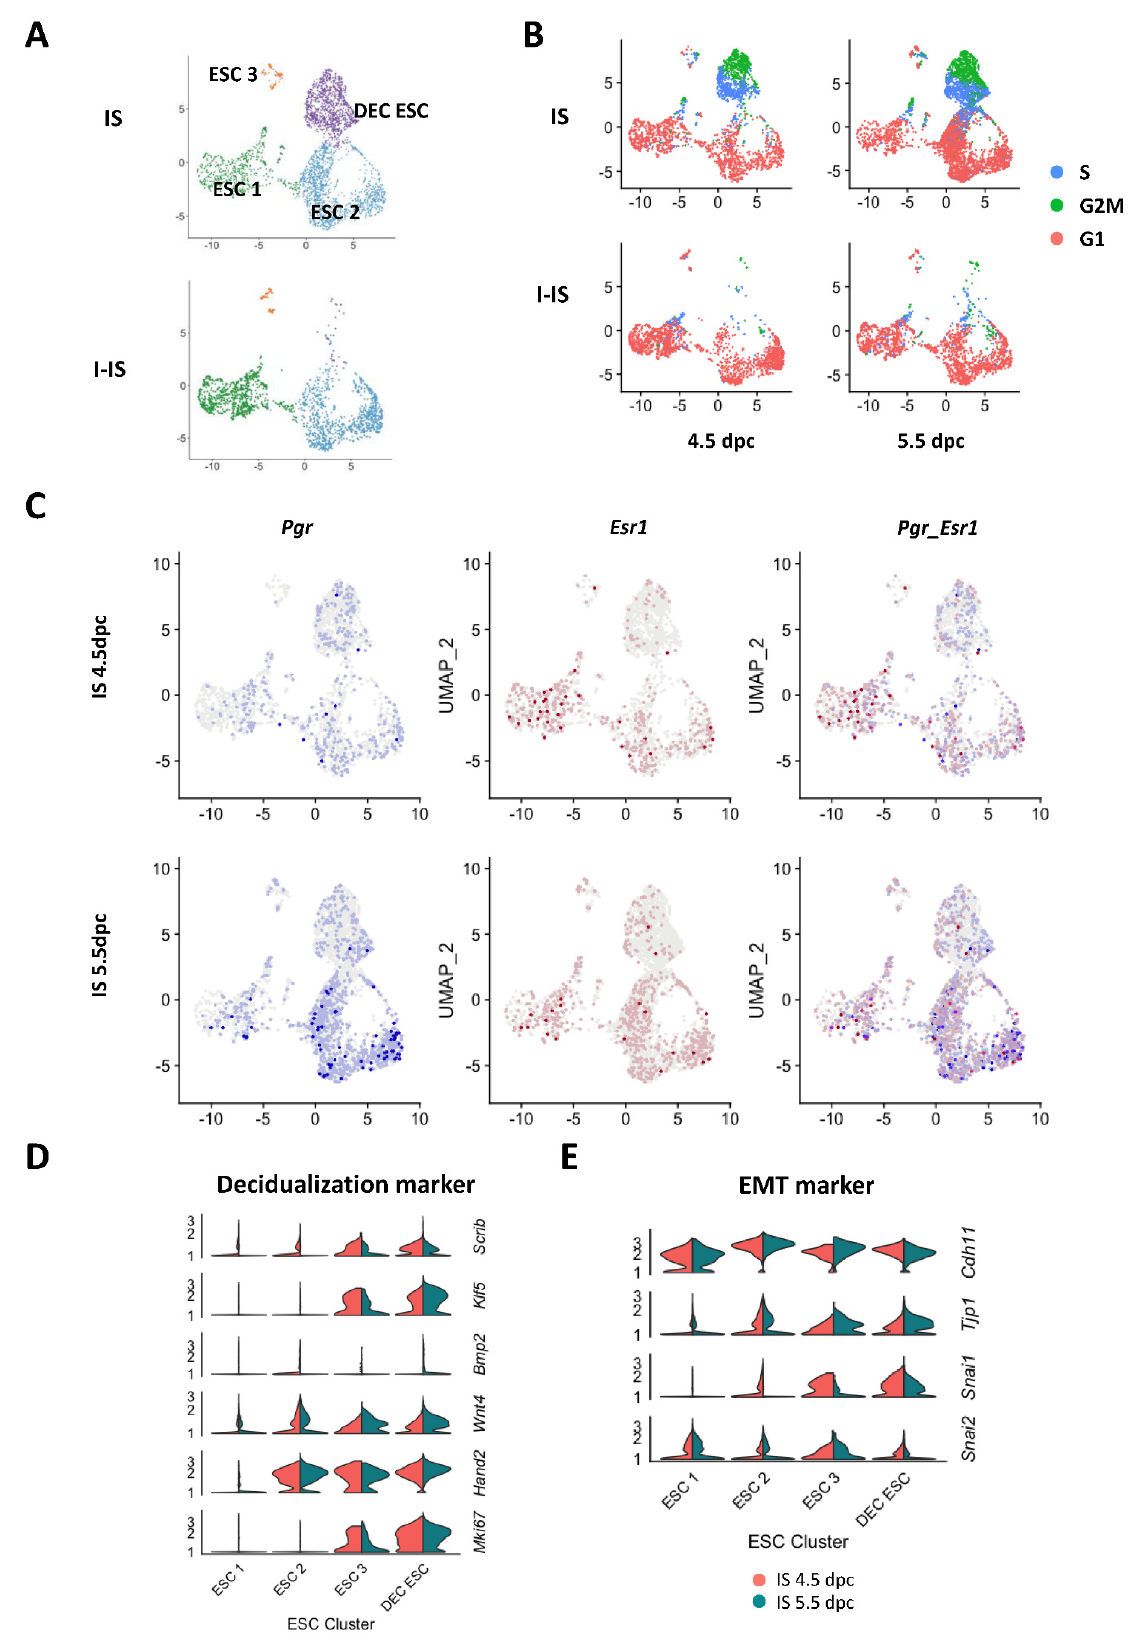
Figure 2. Endometrial stromal cell (ESC) sub-populations in ISs and I-ISs at 4.5 and 5.5 dpc. ( A )